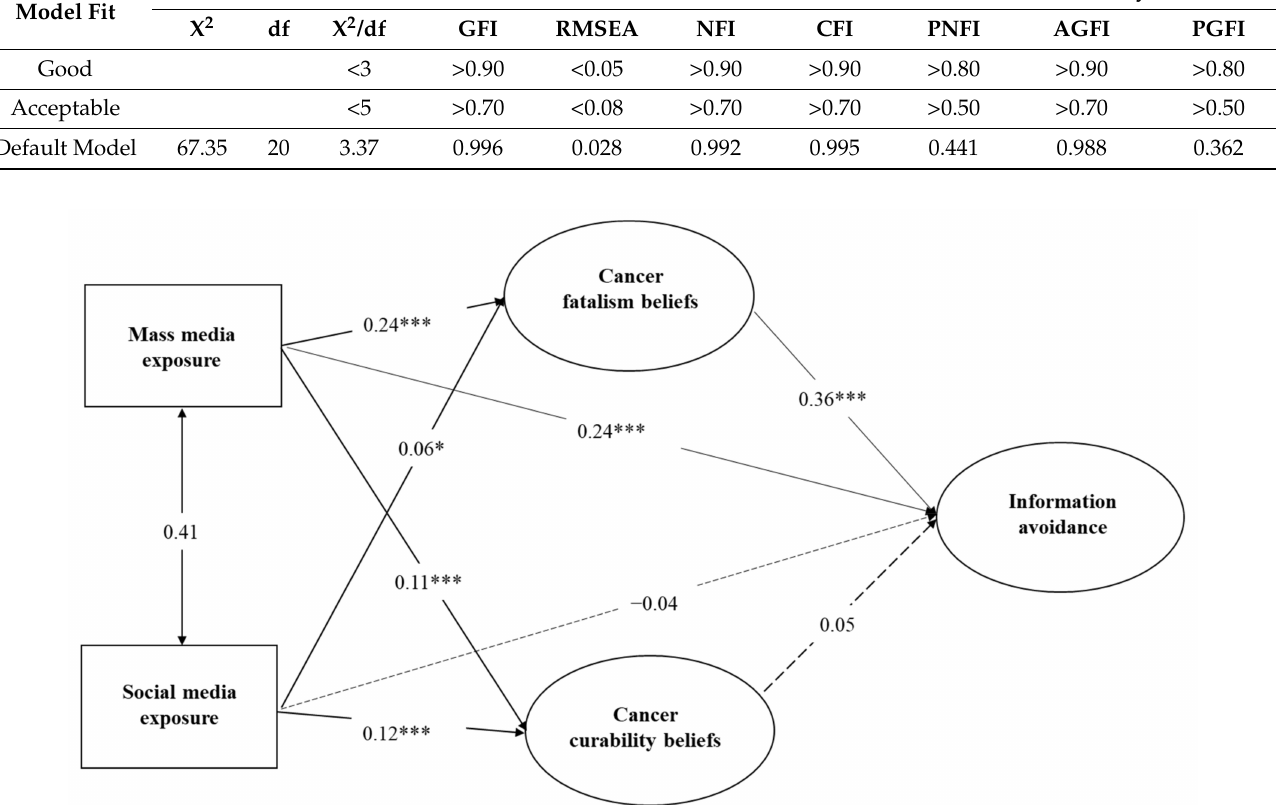
Figure 3. Path analysis of cancer information avoidance (Model 1). Notes * p < 0.05, *** p < 0.001.